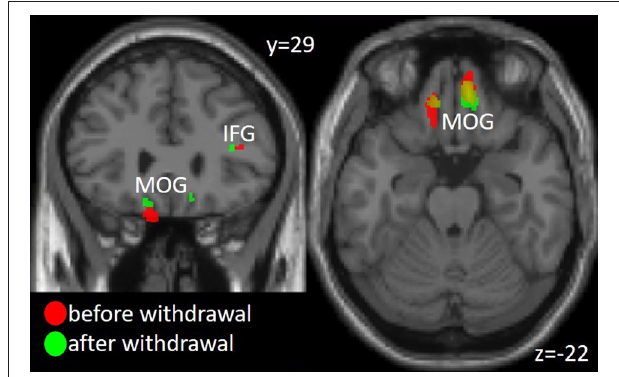
FIGURE 1 | Gray matter volume decrease in Medial Orbital Gyrus (MOG) and Inferior Frontal Gyrus (IFG) in the patient group compared to the healthy controls before and after medication withdrawal. The threshold for visualization is set to p < 0.001 uncorrected with a minimal cluster extent of 20